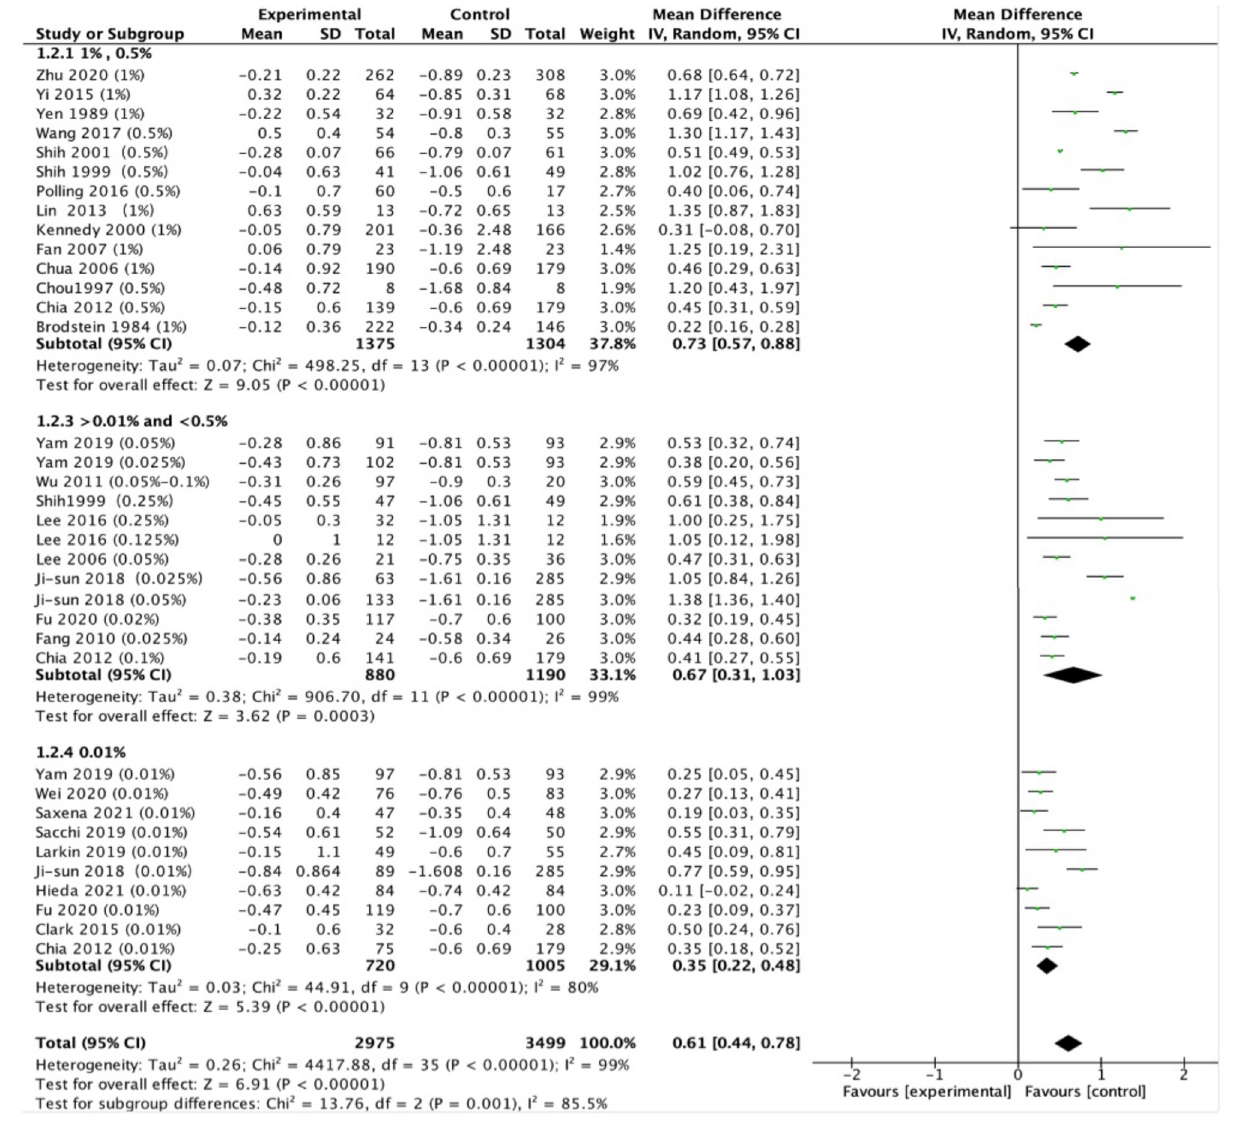
finding that there was a significant interactive effect between doses of atropine and ethnicity on mean annual refraction change ( Table 2 ; P -interaction = 0.006). Further analysis found that there was significant difference in refraction changes among various doses of atropine in Asian population ( P =